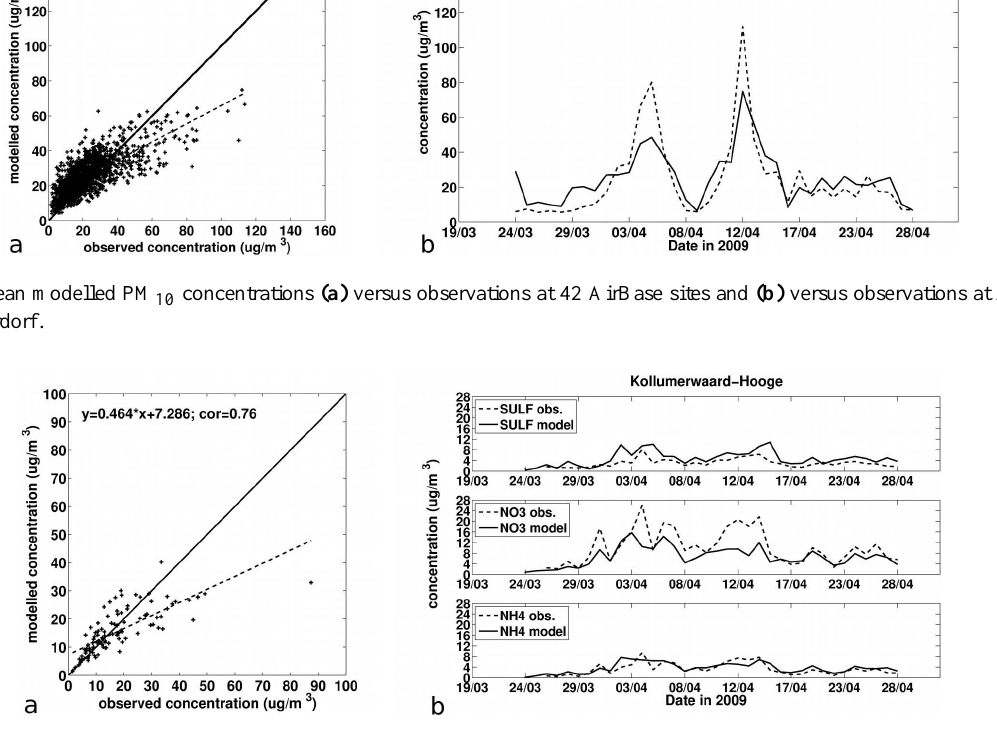
Fig. 6. Daily mean modelled SIA concentrations (a) versus observations at 3 RIVM sites and (b) versus observations at station Kollumer-